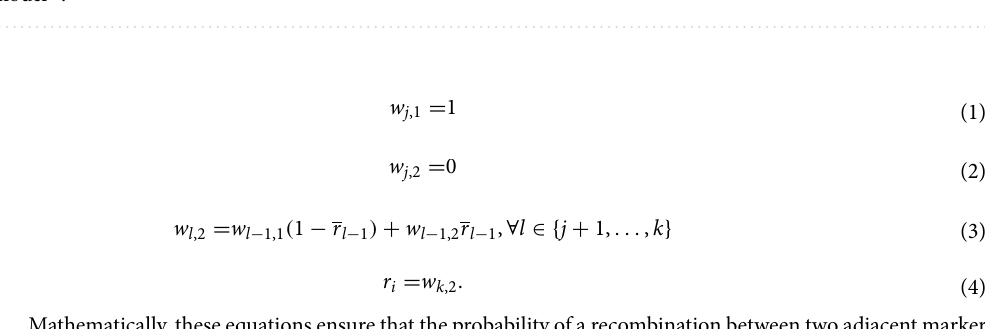
Figure 3. Illustration of relationship between recombination frequencies r i and r j , ..., r j + k − 1 using a water pipe model 27